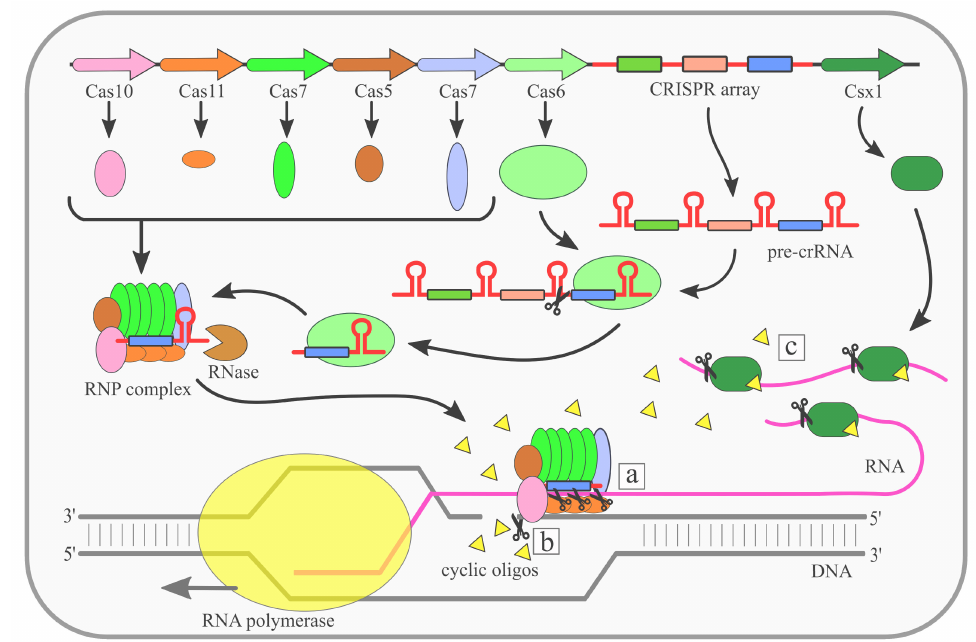
Figure 1. Mechanism of the Clustered Regularly Interspaced Short Palindromic Repeats (CRISPR)–CRISPR-associated(Cas)typeIII(Csm / Cmr)system. Cas6endoribonucleasecleavespre-CRISPR RNA (pre-crRNA) within the repeat region. Subsequently, the ribonucleoprotein (RNP) complex is assembled, while the 3 (cid:48) end of crRNA is trimmed by an unknown nuclease. There are three nuclease activities of the RNP complex: ( a ) specific RNA cleavage, ( b ) non-specific ssDNA cleavage, ( c ) non-specific RNA degradation (details in the main